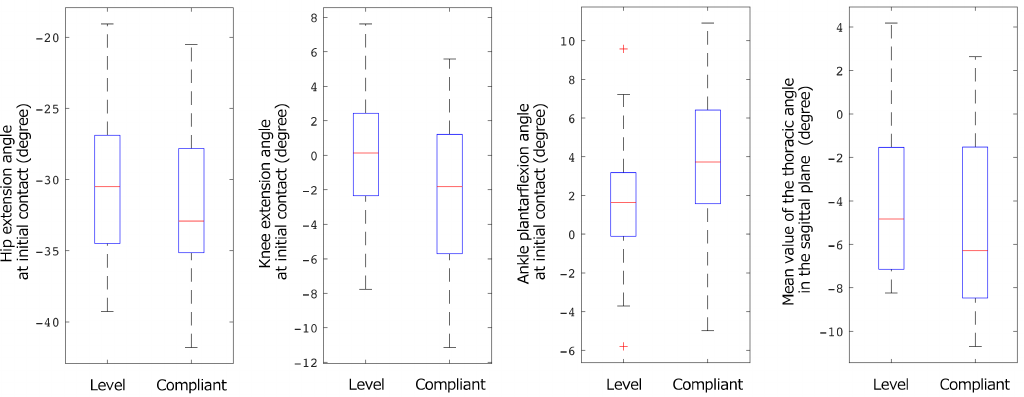
Figure 4. Boxplot of joint angle during gait on the level surface and compliant surface. A red plus sign is an outlier.